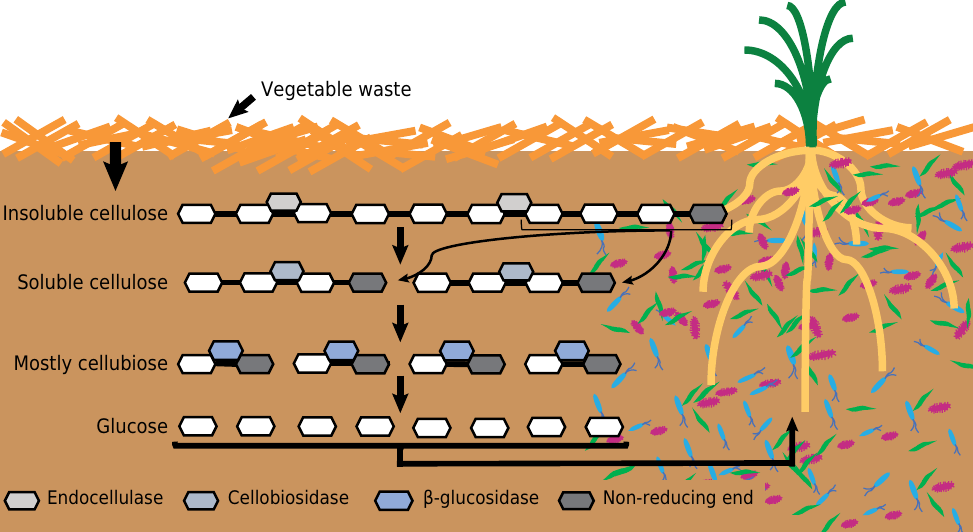
Figure 1. Soil enzymes linked to carbon in the decomposition process of plant residues. Source: Adapted from Wallenstein and Burns (2011).